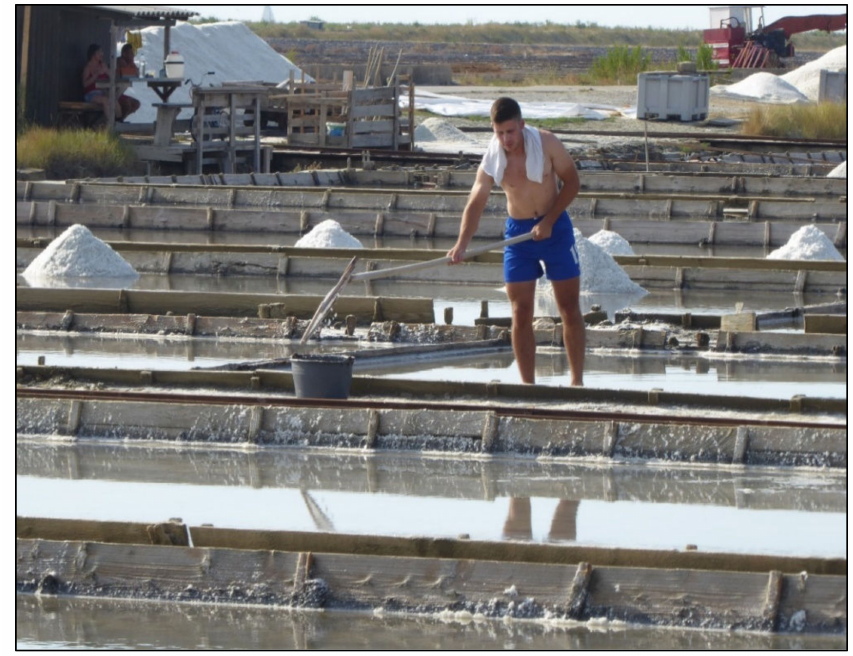
Figure 8. Salt worker harvesting salt in Lera, according to methods used in the salinas of the Adriatic basin in the 15th century onwards. Own